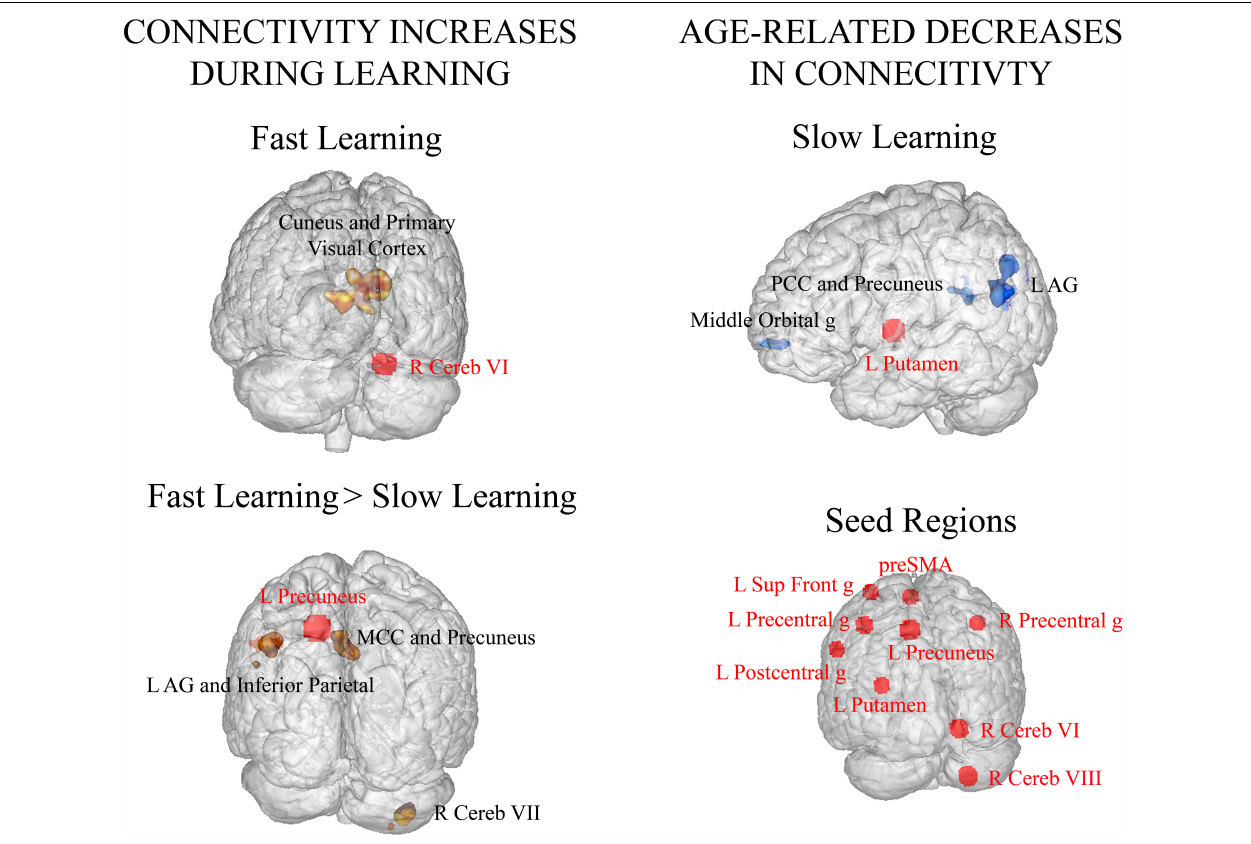
FIGURE 3 | Seed-to-voxel functional connectivity analyses [ p < 0.0055 (after Bonferroni correction for multiple seeds), FWE corrected at cluster-level -voxel defining threshold p = 0.001]. Seed regions are displayed with red circles and red font and their targets with black font. (Left column) Functional connectivity increases related to motor learning. (Top row) Significant increases in connectivity during FL compared to rest. (Bottom row) Significant increases in connectivity in FL with respect to SL. (Right column) (Top row) Age related decreases in functional connectivity during SL vs. rest. (Bottom row) Seed regions included in the connectivity analyses. R: right, L: left, AG: angular gyrus, MCC: middle cingulate cortex, PCC: posterior cingulate cortex, g: gyrus.